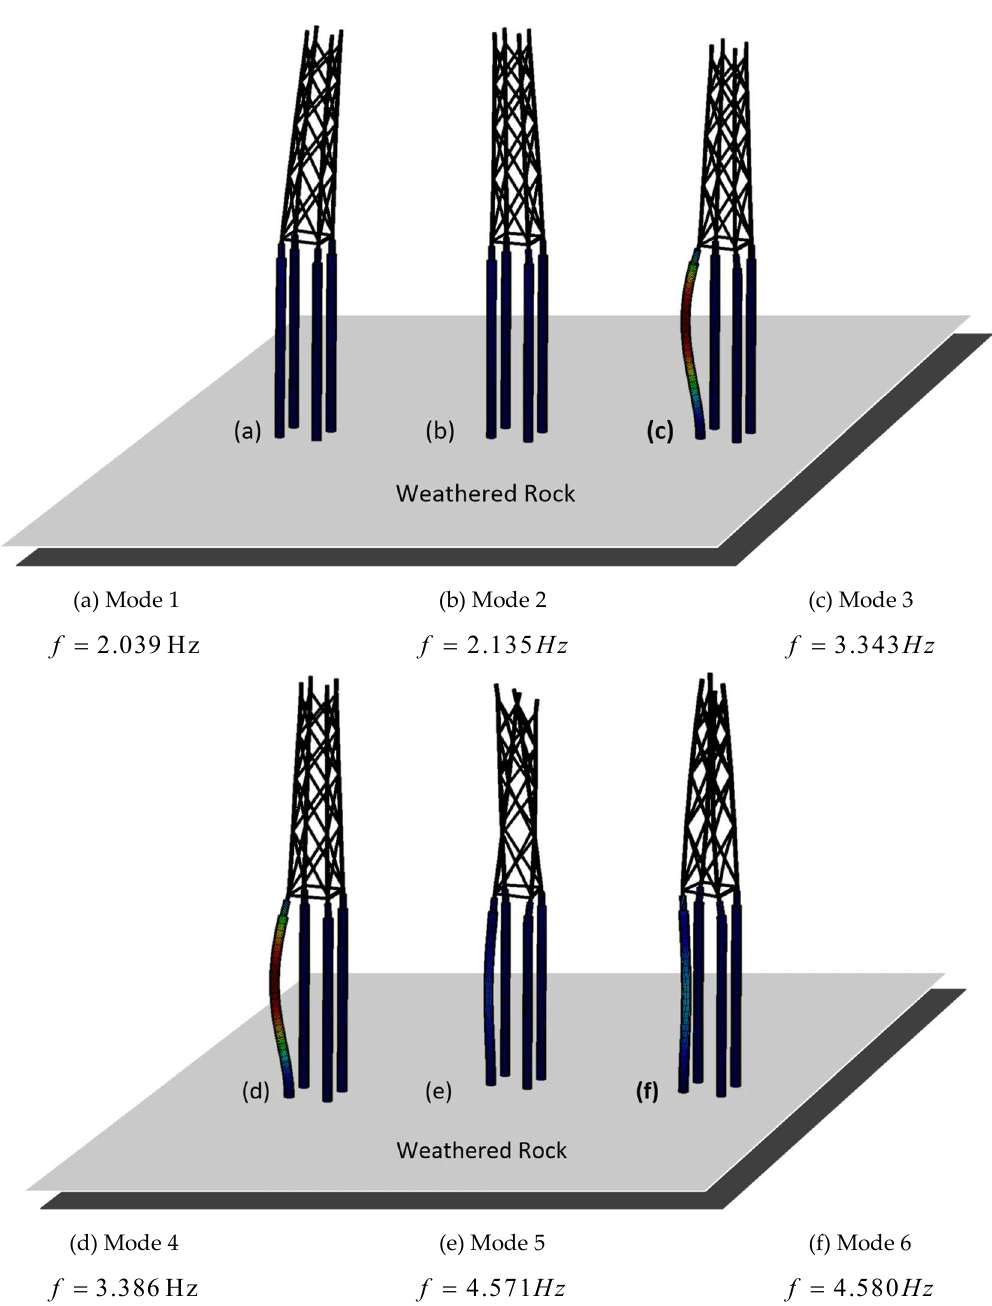
Figure 14. The natural frequencies and mode shape of piled support structure (scaling factor = 25).